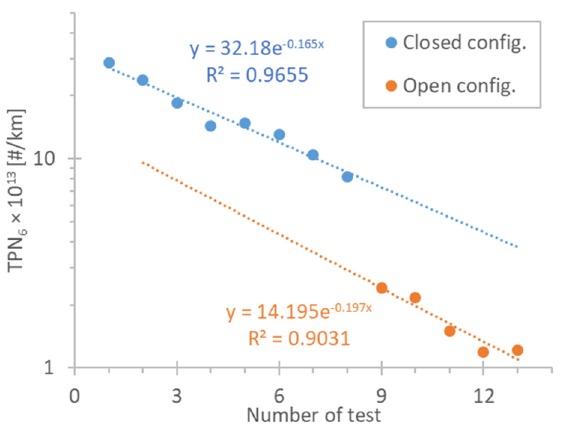
Figure 8. Total particle number >6 nm (TPN 6 ) emissions of the third phase of the WMTC (World Harmonized Motorcycle Test Cycle) over consecutive tests. Harmonized Motorcycle Test Cycle) over consecutive